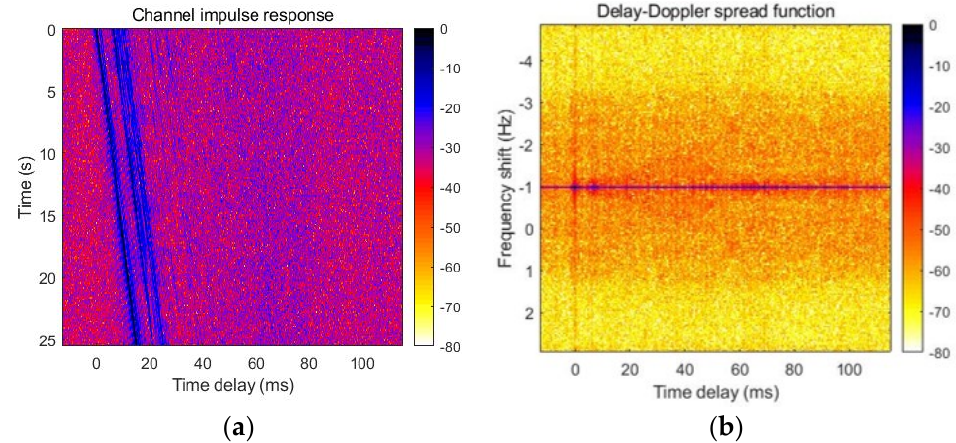
Figure 7. C hannel characteristic: ( a ) Channel impulse response and ( b ) Doppler spread. Figure 7. Channel characteristic: ( a ) Channel impulse response and ( b ) Doppler spread.